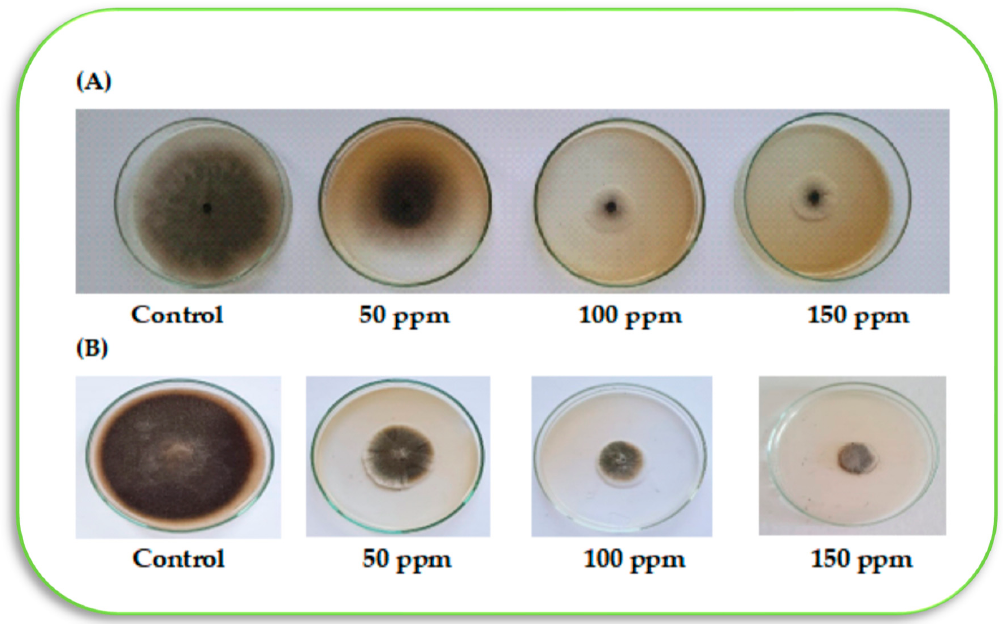
Figure 10. Our previous study using PBZ on the mycelial growth of Macrofomina, as shown in ( A ), whereas ( B ) presents the impact of PBZ on the growth of Alternaria . This study confirmed that applied dose of 100 ppm of PBZ might show the priority in our current study .